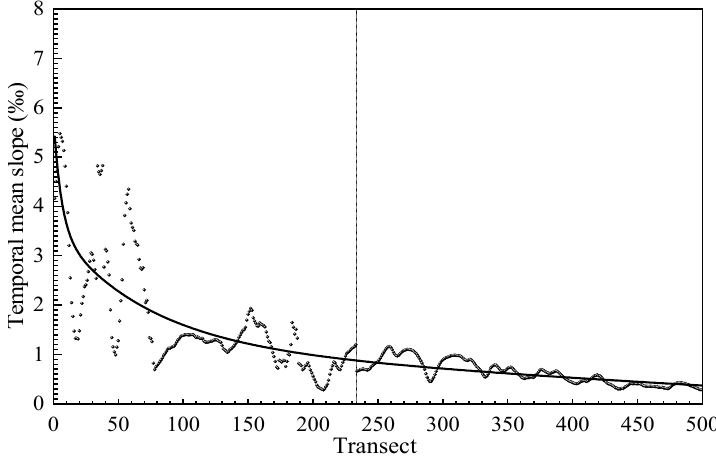
Figure 12. The spatial distributions of intertidal zone slope.